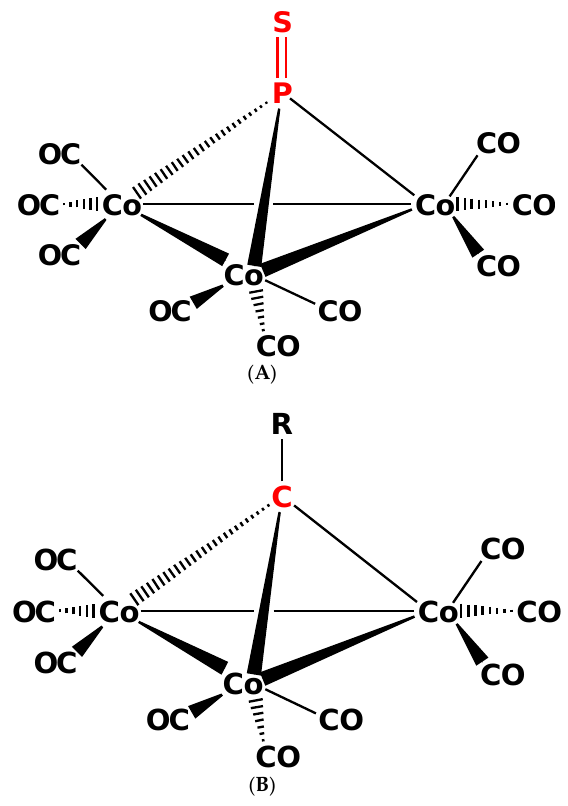
Figure 2. Schematic views of the structures of complex 2 ( A ) [1,2] and of its organic analog, (μ 3 -RC)Co 3 (CO) 9 ( 3Co–Co ), R = organic groups, halogens, etc. ( B ) [4,5].